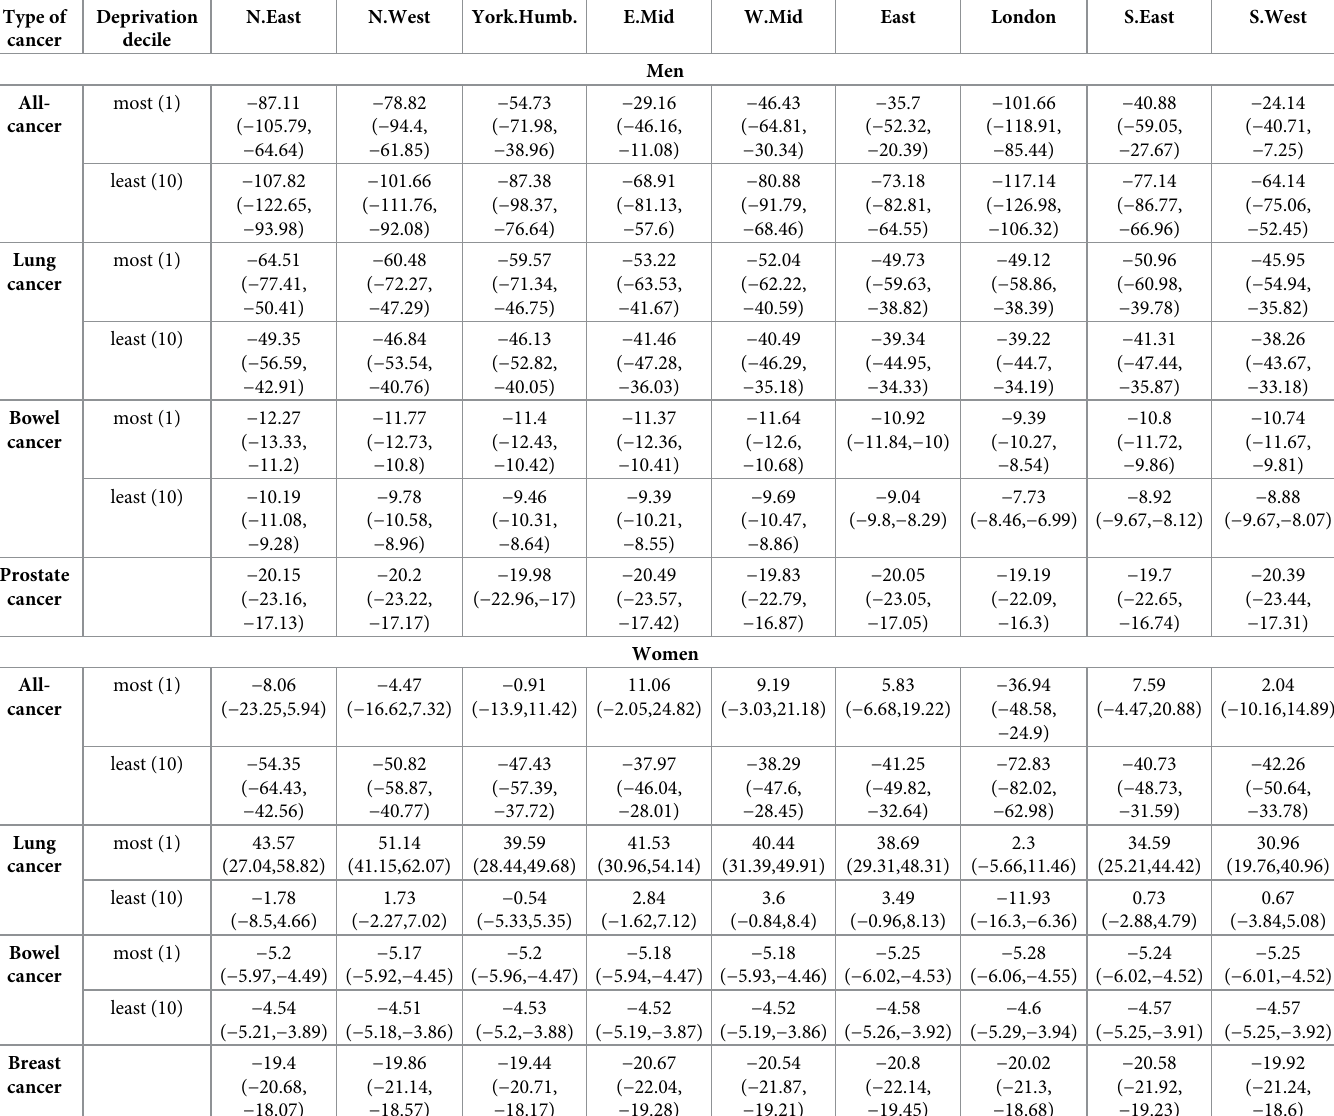
Table 6. Overall-temporal-changes (AC d , r , per 100,000 people) from 2001 to 2016, in age-standardised fitted mortality rates for deprivation levels 1 and 10 and all regions in England for both genders; 95% credible intervals in brackets. Type of Deprivation cancer